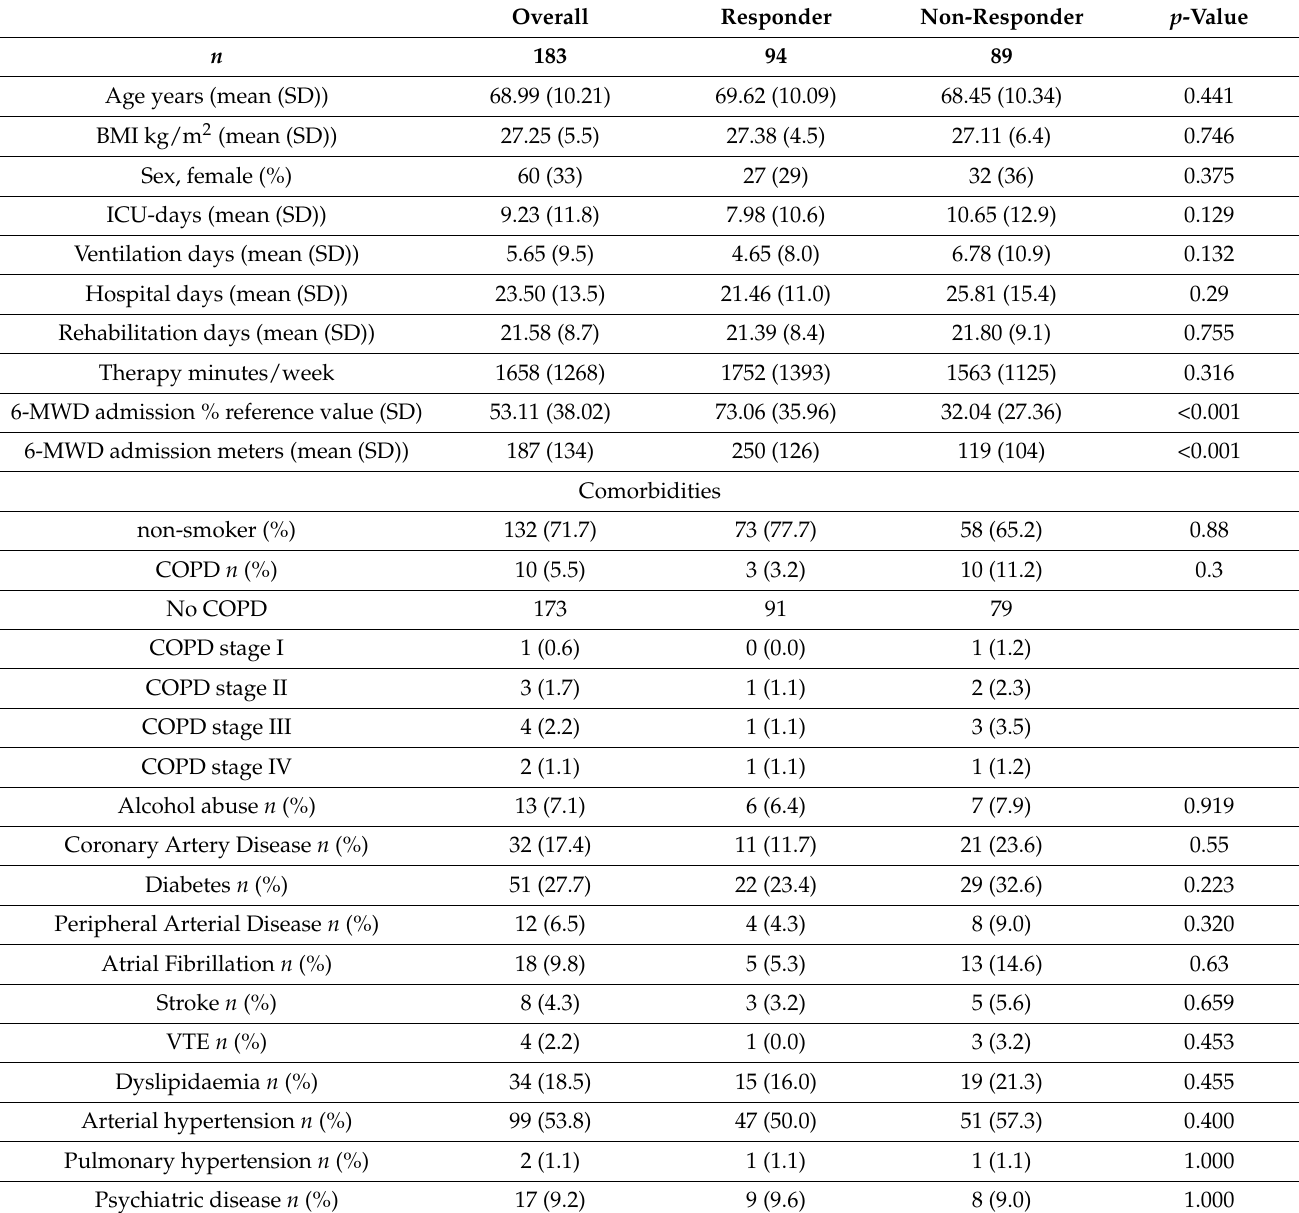
Table 1. Baseline Characteristics of Responders and